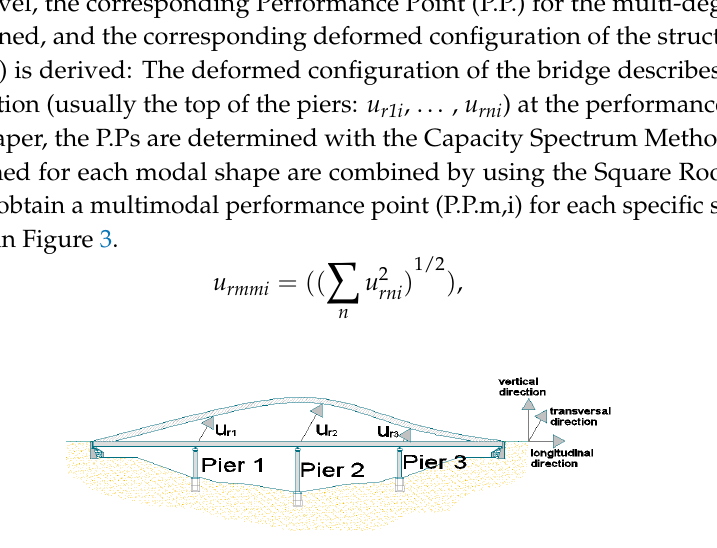
Figure 2. Degree of freedom of the bridge: by performing the NSA, the displacement u r of the monitoring point is controlled. In this work, u r is the transversal displacement.